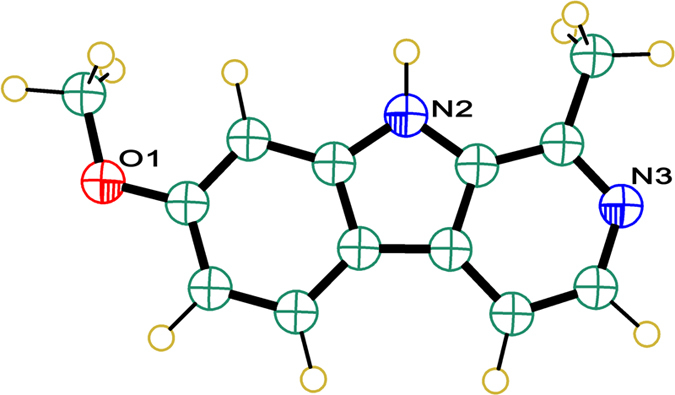
Structure of HM.